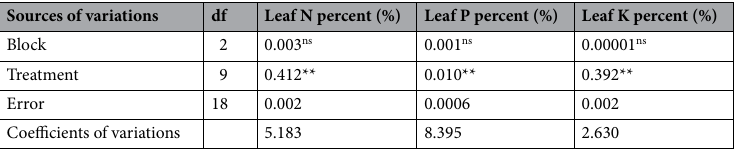
Table 3. The results of analysis of variance for the effect treatment on the accumulation of NPK in leaves. ns non-significance; *significance at the p < 0.05 level; **significance at the p < 0.01 level.